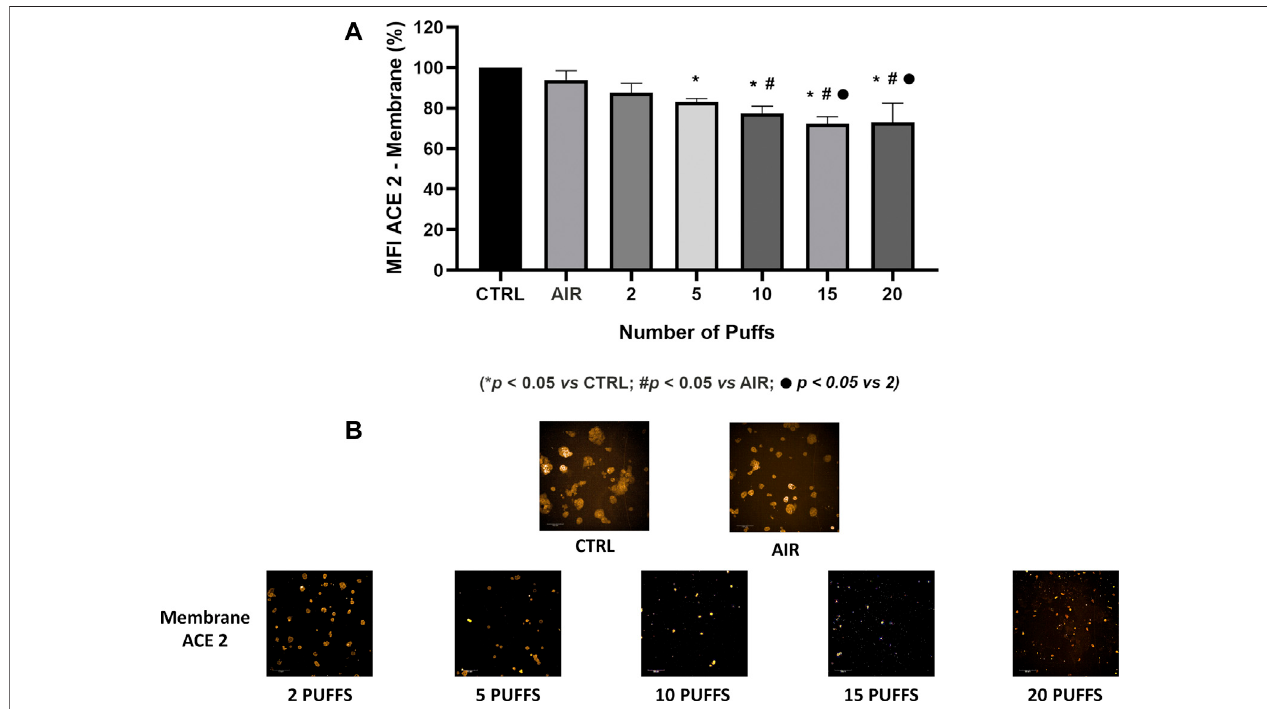
FIGURE 1 | Quanti fi cation of membrane ACE-2 expression normalized to live cells, following membrane segmentation by HCS using the Harmony software (A) . Representative images ofimmunocytochemistry ofmembrane ACE-2 expression following exposureto increasing number ofpuffs of cigarette smoke (B) . Images were used for segmentation and protein expression quanti fi cation on cell membranes.